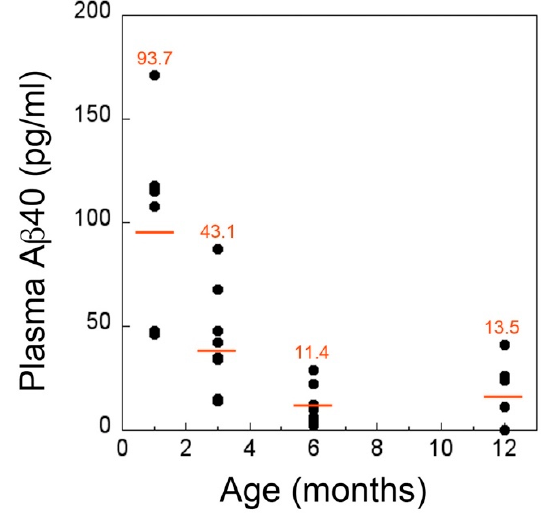
Figure 6. Decreased levels of A β 40 in plasma of rTg-DI rats at the inception and progression of microvascular CAA. The levels of A β 40 in plasma collected from rTg-DI rats as they aged from one to twelve months was determined by ELISA. The data show the mean plasma A β 40 levels at each time point from n = 6–8 rTg-DI rats per group. At three months of age, when CAA first appears, there is marked reduction in plasma A β 40 levels that continue to decline with progressing CAA.